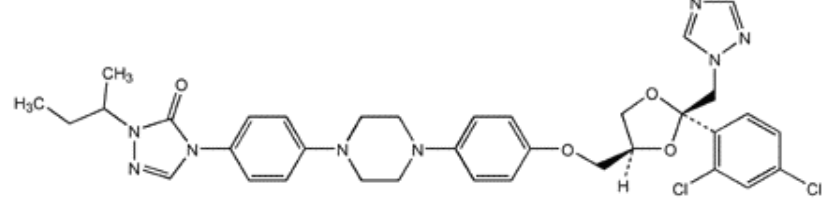
FIGURE 4 . Chemical structure of itraconazole